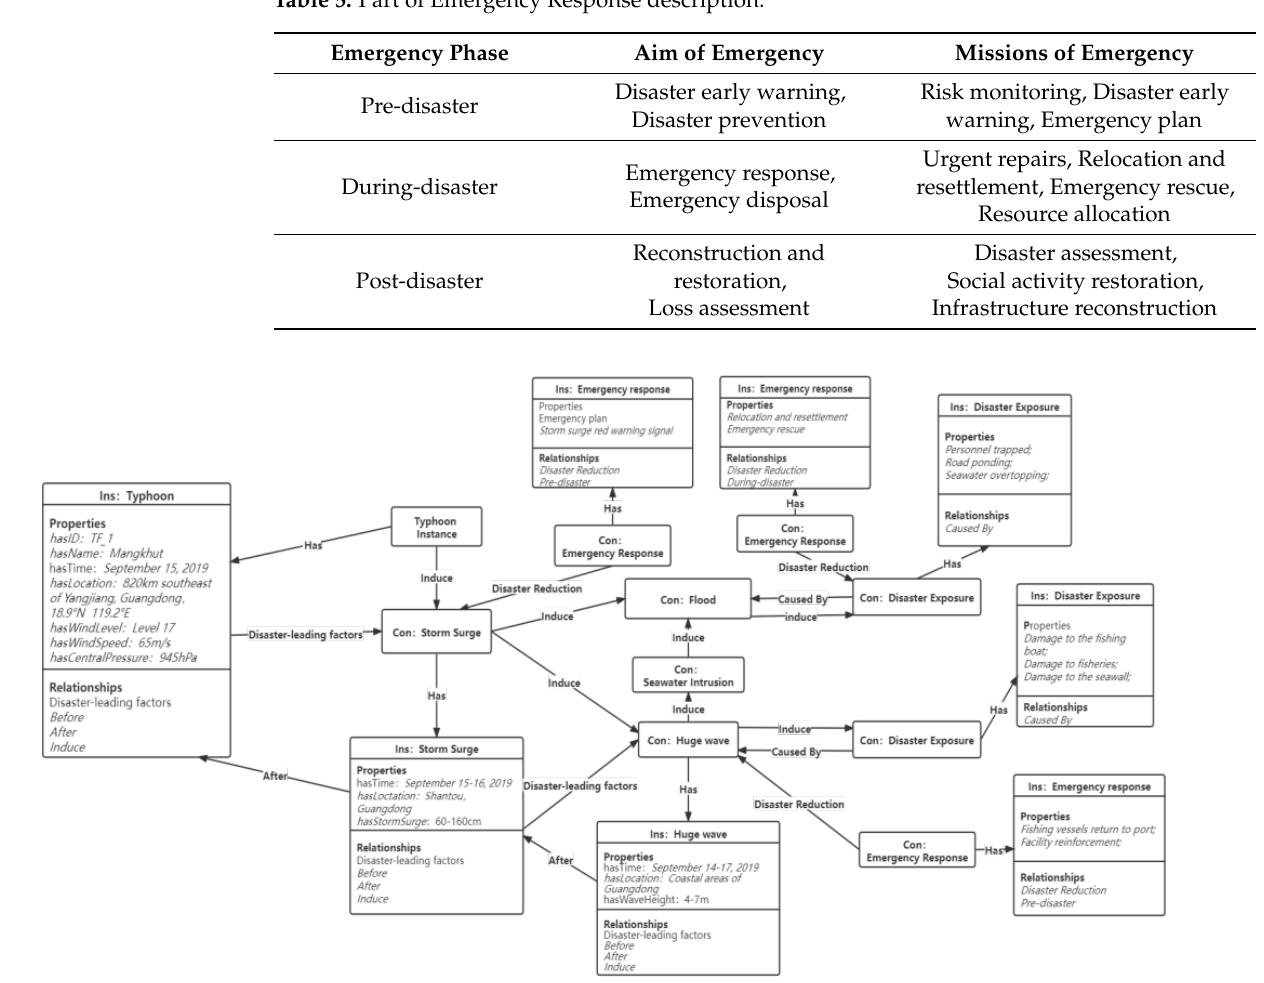
Table 5. Part of Emergency Response description.